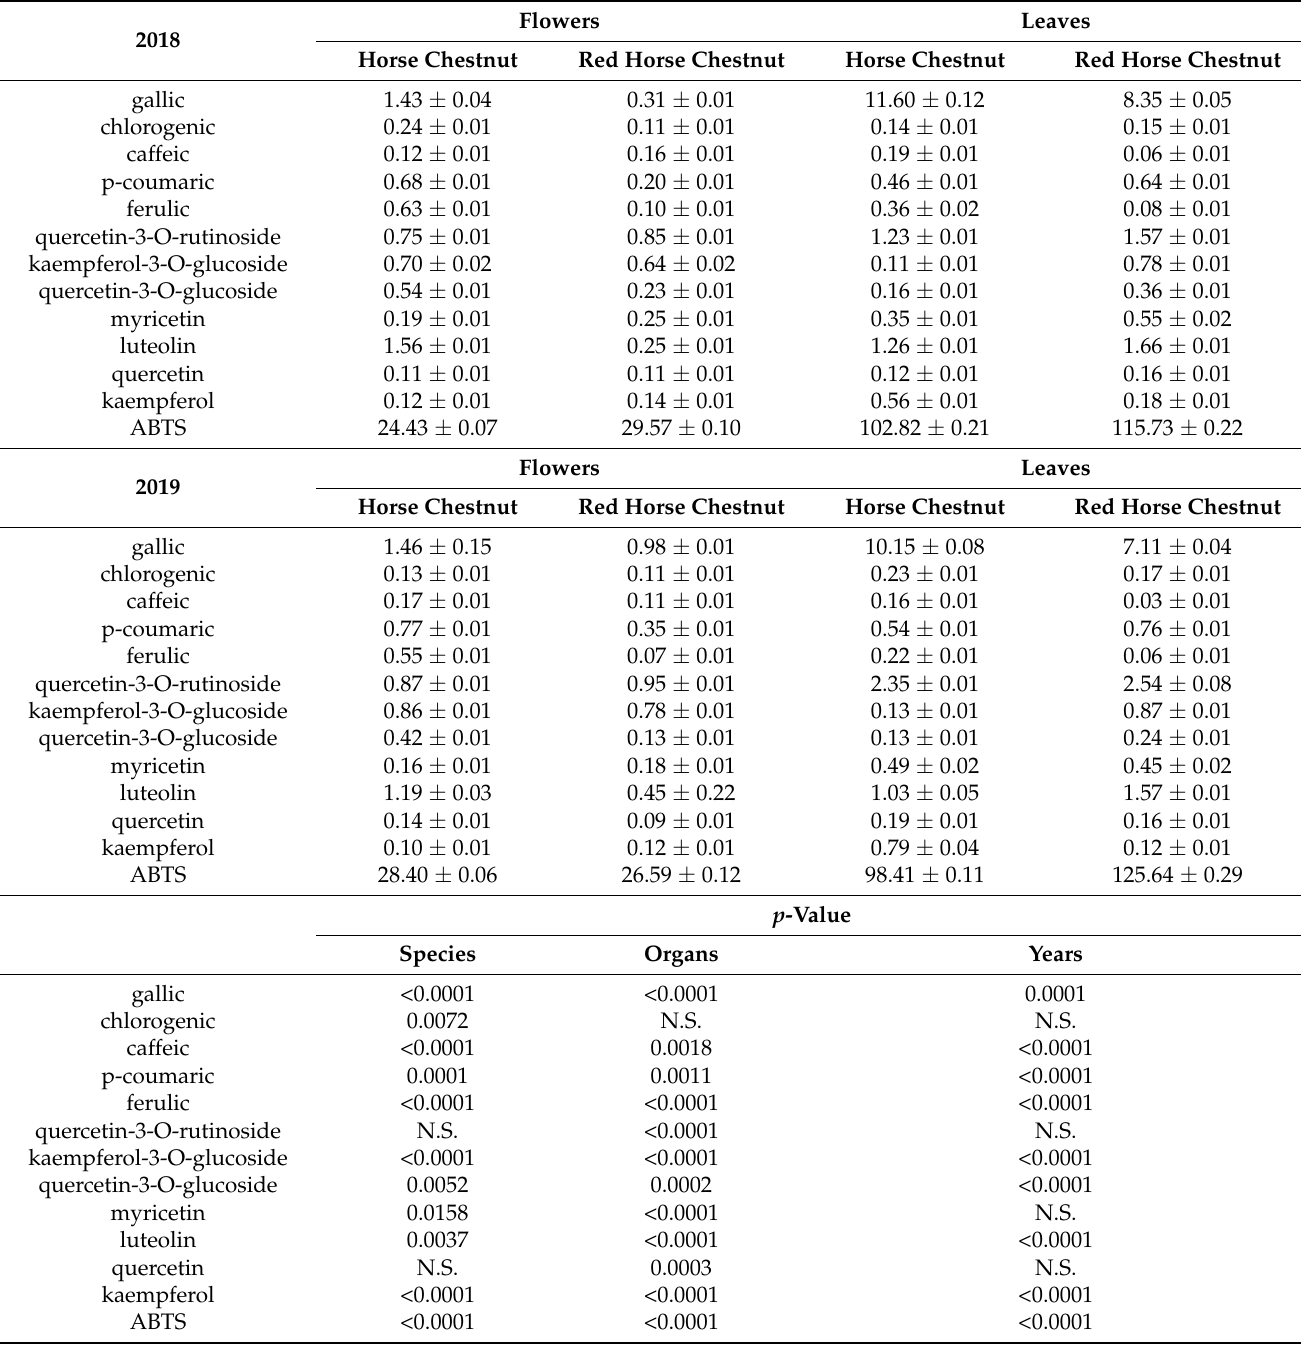
Table 4. Content of identified phenolic acids and flavonoids (mg/g FW) and antioxidant activity (mMol/100 g FW) in both species of horse chestnuts’ flowers and leaves (mean value ± standard error). N.S (statistically not